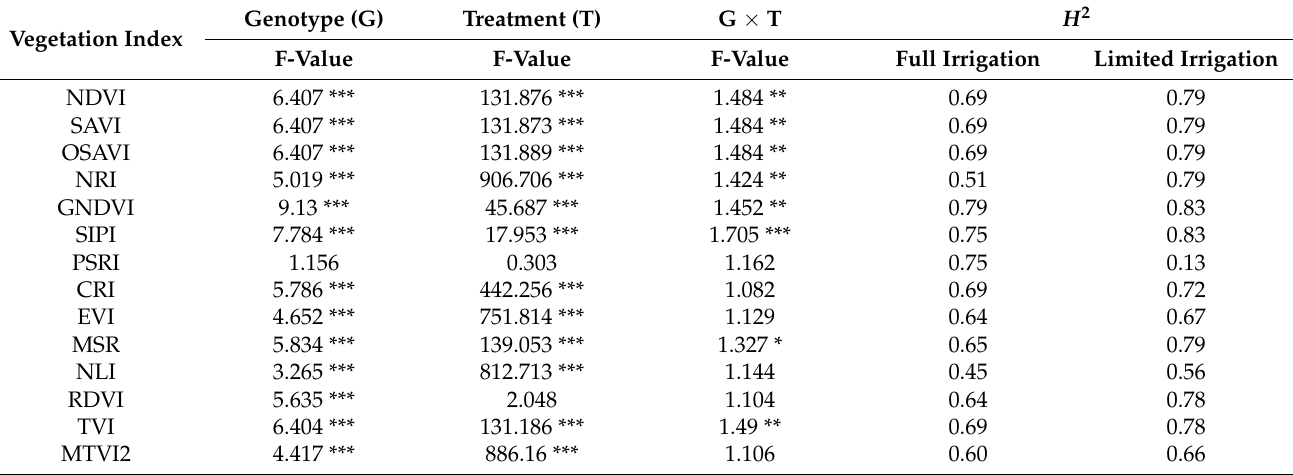
Table A4. Significance test and heritability of the vegetation indexes extracted in the early grain filling